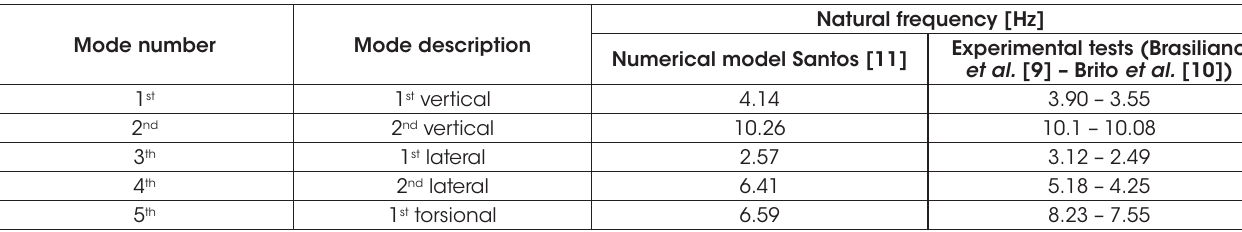
Comparison of the results of natural frequencies obtained from free vibration analysis of the horizontal span footbridge over the E.P.I.A. ( Estrada Parque Indústria e Abastecimento )